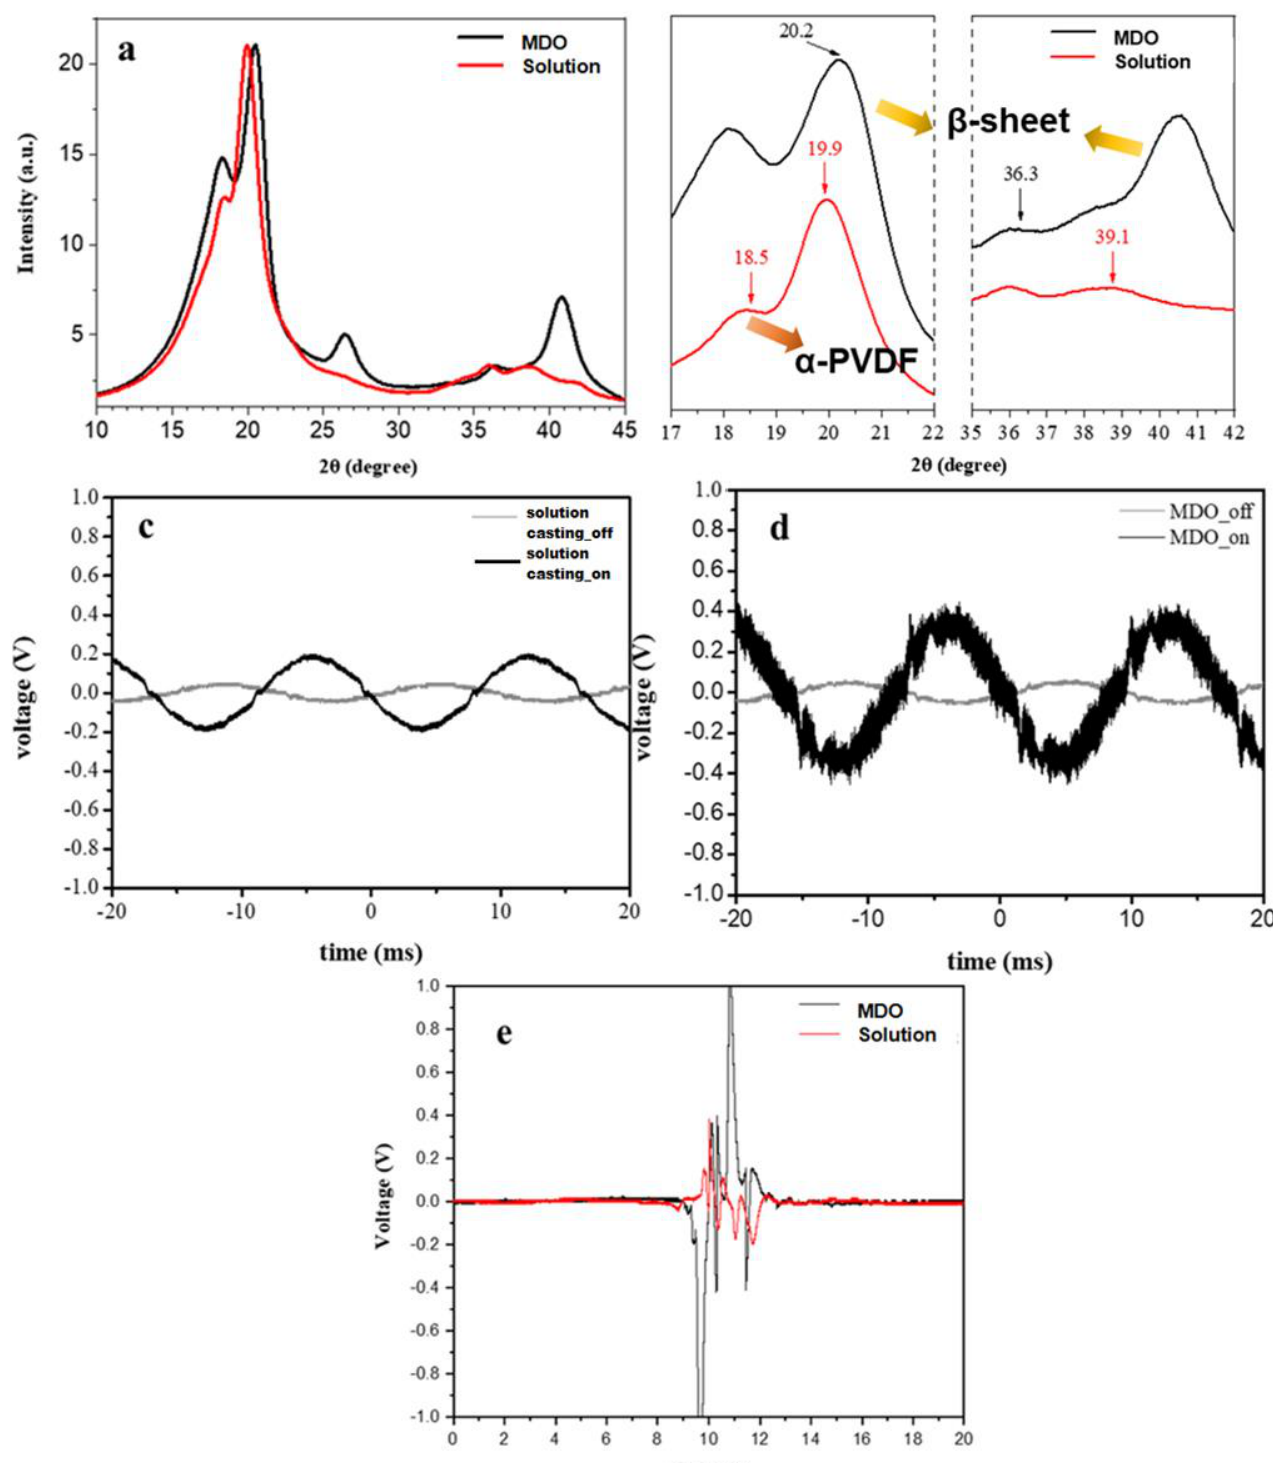
Figure 5. XRD results of PVDF films formed by different process methods: ( a ) overview, ( b ) partial enlargement, piezoelectrical performance with respect to time ( c , d ), and with an applied pressure of 1 N/cm − 1 ( e ).